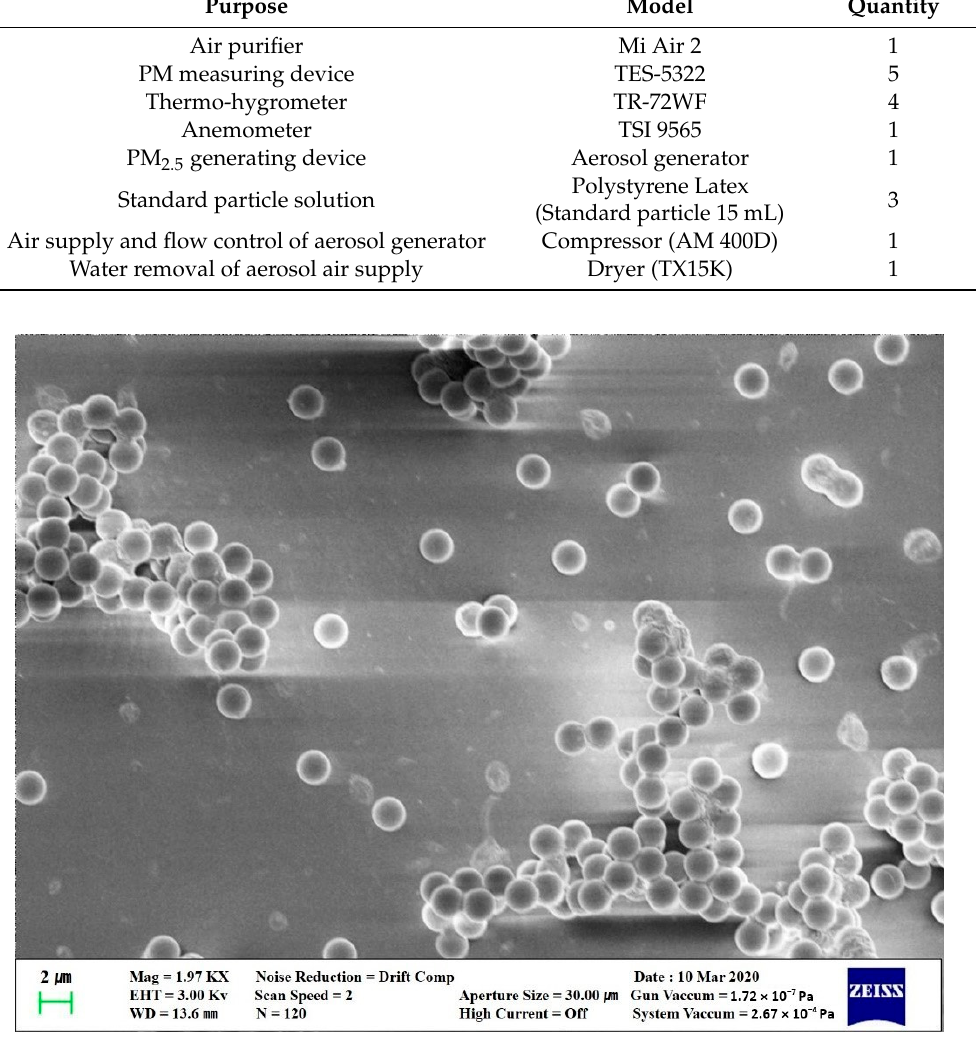
Figure 2. Expanded picture of standard solution through a scanning electron microscope (SEM).